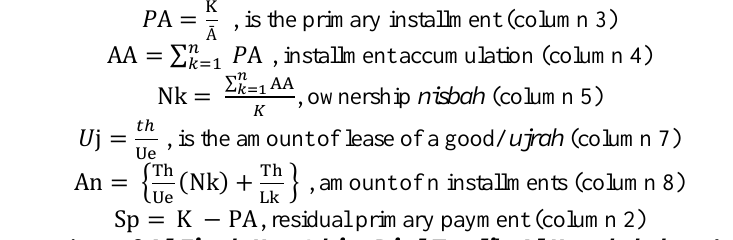
, is the primary installment (column 3) 𝑃A = K Ᾱ AA = ∑ , installment accumulation (column 4) 𝑛 𝑘=1 , ownership nisbah (column 5) Nk = ∑ AA 𝐾 , is the amount of lease of a good/ ujrah (column 𝑈j = 𝑡ℎ Ue